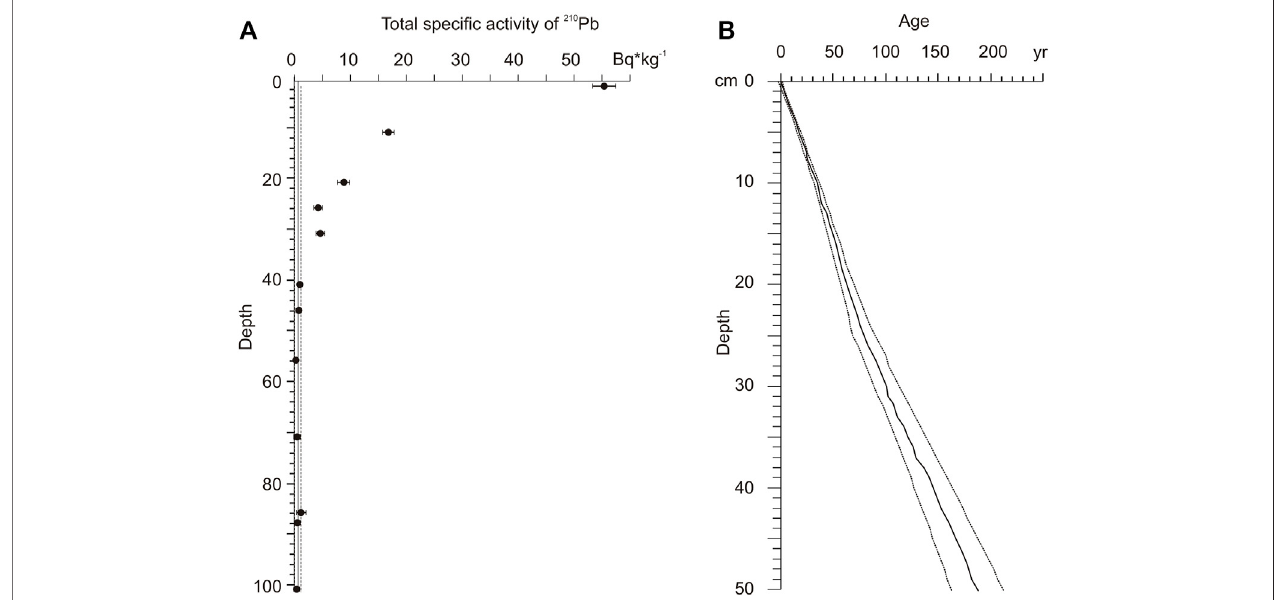
FIGURE4|(A) Totalspeci fi cactivityof210 PbinsedimentsofZaton2;thesolidlineisacalculatedvalueofsupported210 Pb. (B) Age-depthmodel(solidline)with the 2SD con fi dence band (dashed lines) for the Zaton2 sediment sequence based on 210 Pb dating.